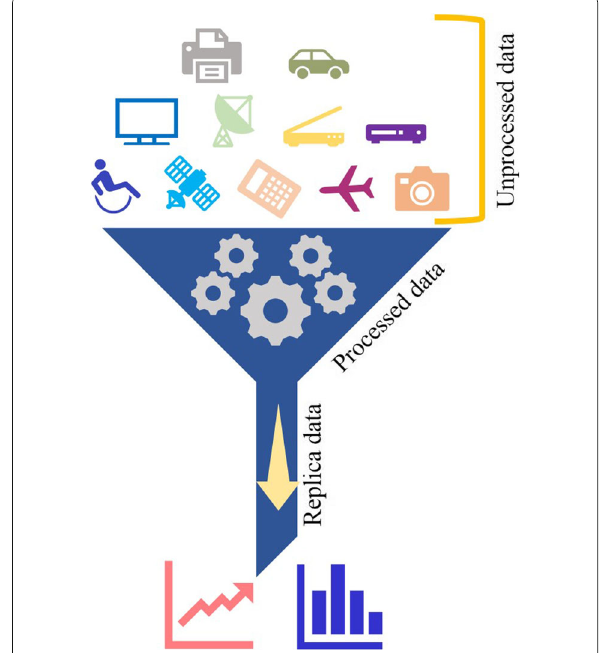
Fig. 1 IoT dataset categorization through Stream Engines